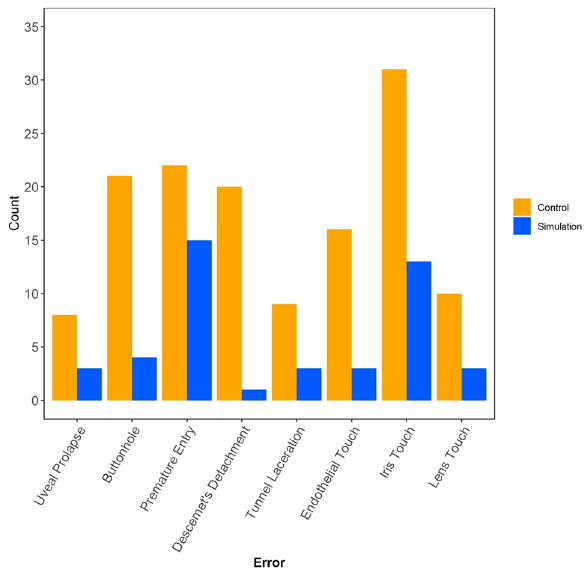
Figure 4. Counts of individual errors observed in the initial 20 procedures performed by TCC-PASTE participants.